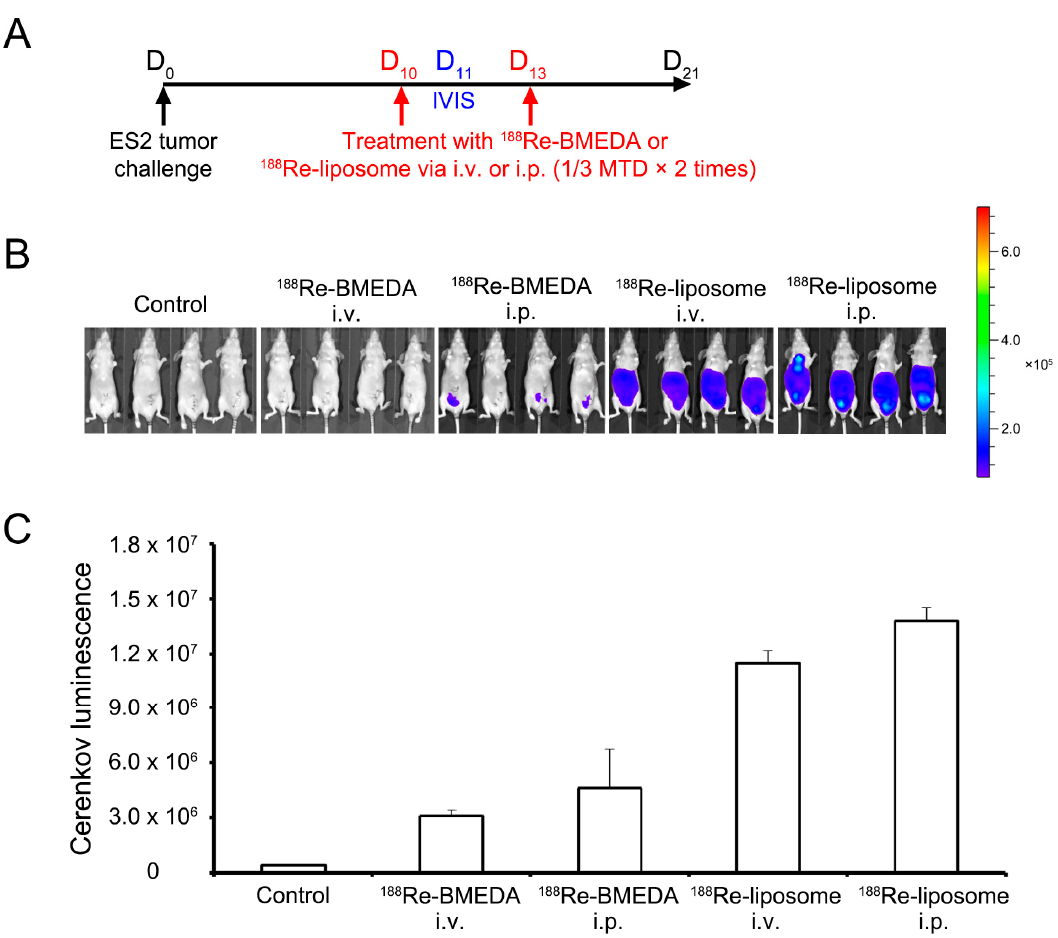
Figure 2. In vivo 188 Re-liposome retention radioactivity in the xenograft mice model. ( A ) Schematic diagram of the treatment regime showing the timing schedule; ( B ) Luminescence images of representative mice receiving various treatment regimens. The color represented the intensity of 188 Re radioactivity from minimum 9 × 10 4 (blue) to maximum 7 × 10 5 (red); ( C ) Sum of quantitative luminescent photons of in vivo imaging system (IVIS) images in ( B ). Data are presented as the mean ± SD with quadruplicates. BMEDA, N , N -Bis(2-mercaptoethyl)- N ′ , N ′ -diethylethylenediamine; MTD, maximal tolerated dose; IVIS, in vivo imaging system; i.v., intravenous; i.p., intraperitoneal.